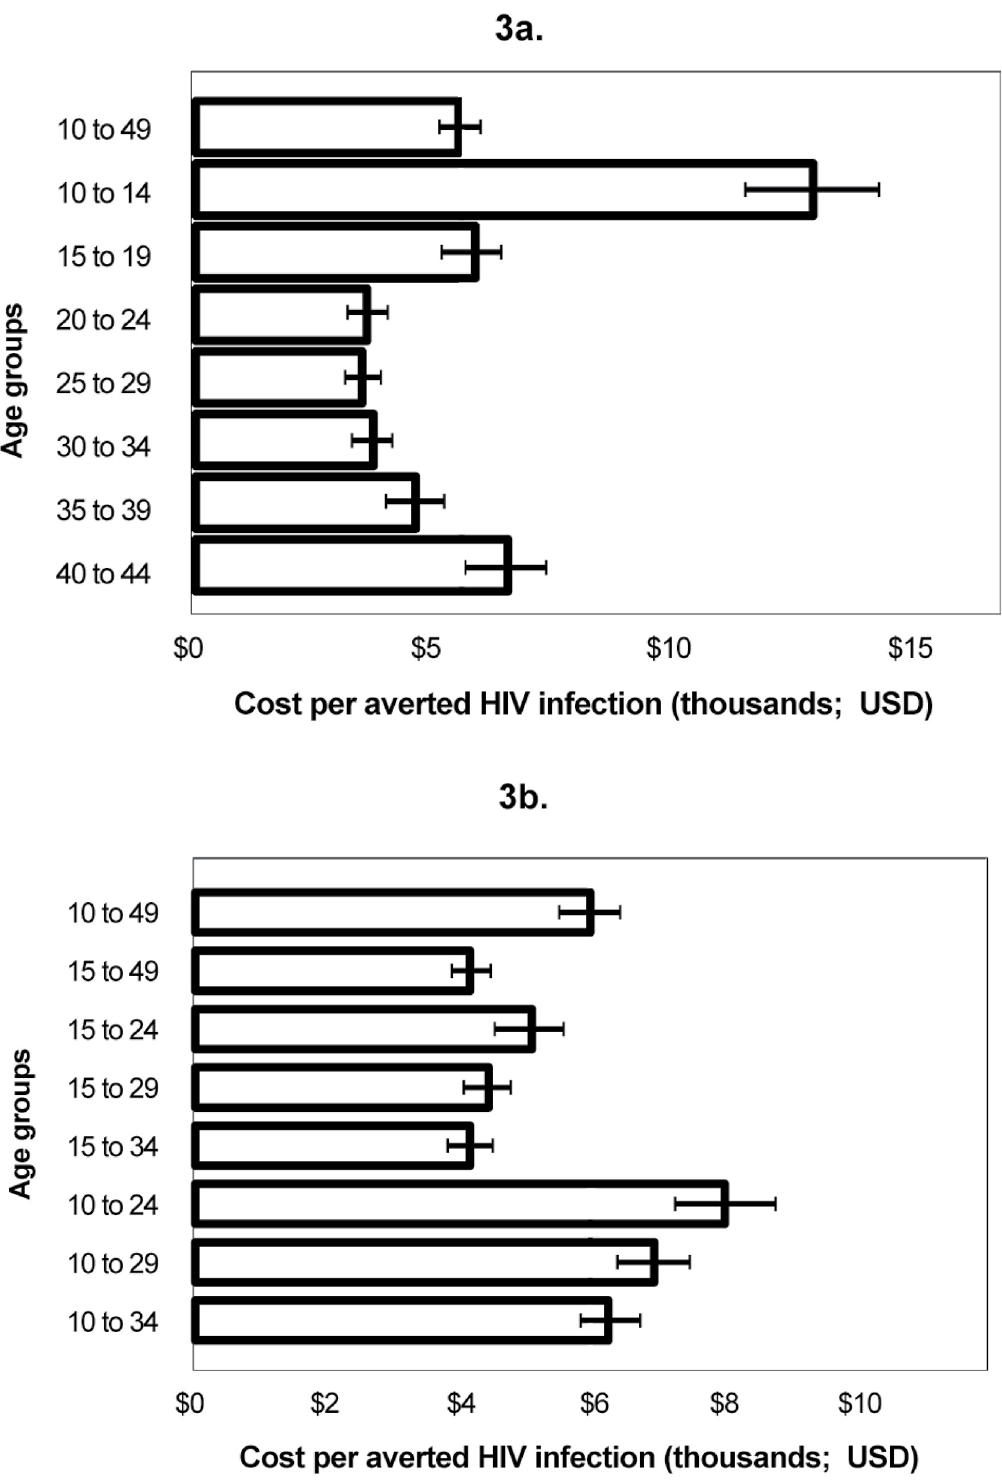
Fig 3. a and b. Cost per HIV infection averted in scenarios scaling up VMMC among different client age groups. The time period for measuring HIV infections averted was 15 years, 2014 – 2028, inclusive. Error bars represent uncertainty